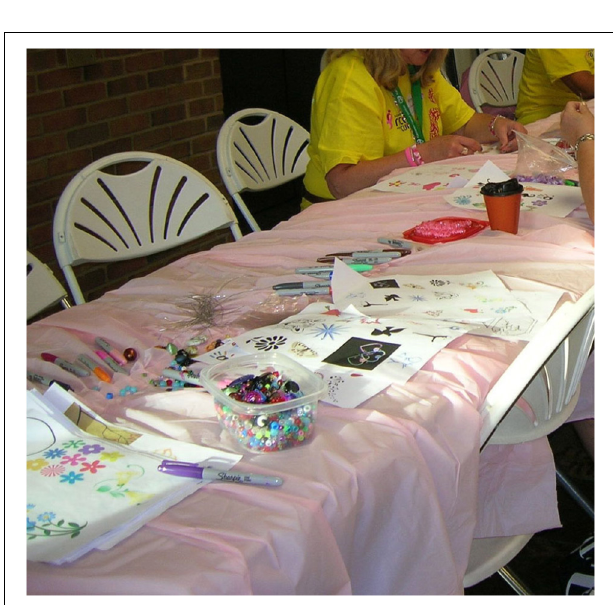
FIGURE 7 | Making commemorative beads at the race to cure cancer.